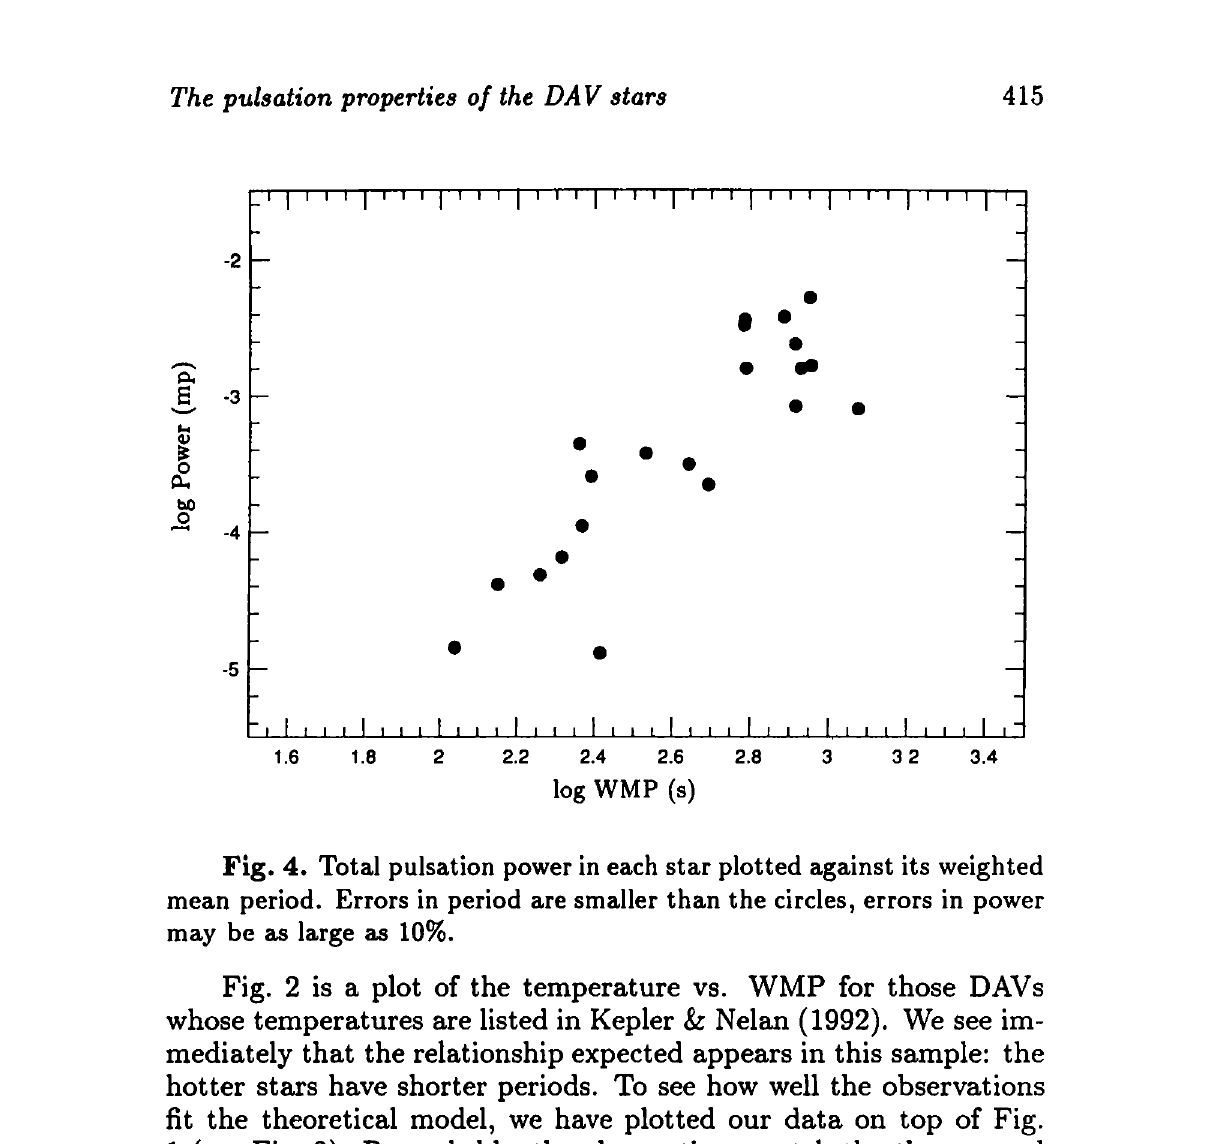
Fig. 4. Total pulsation power in each star plotted against its weighted mean period. Errors in period are smaller than the circles, errors in power may be as large as